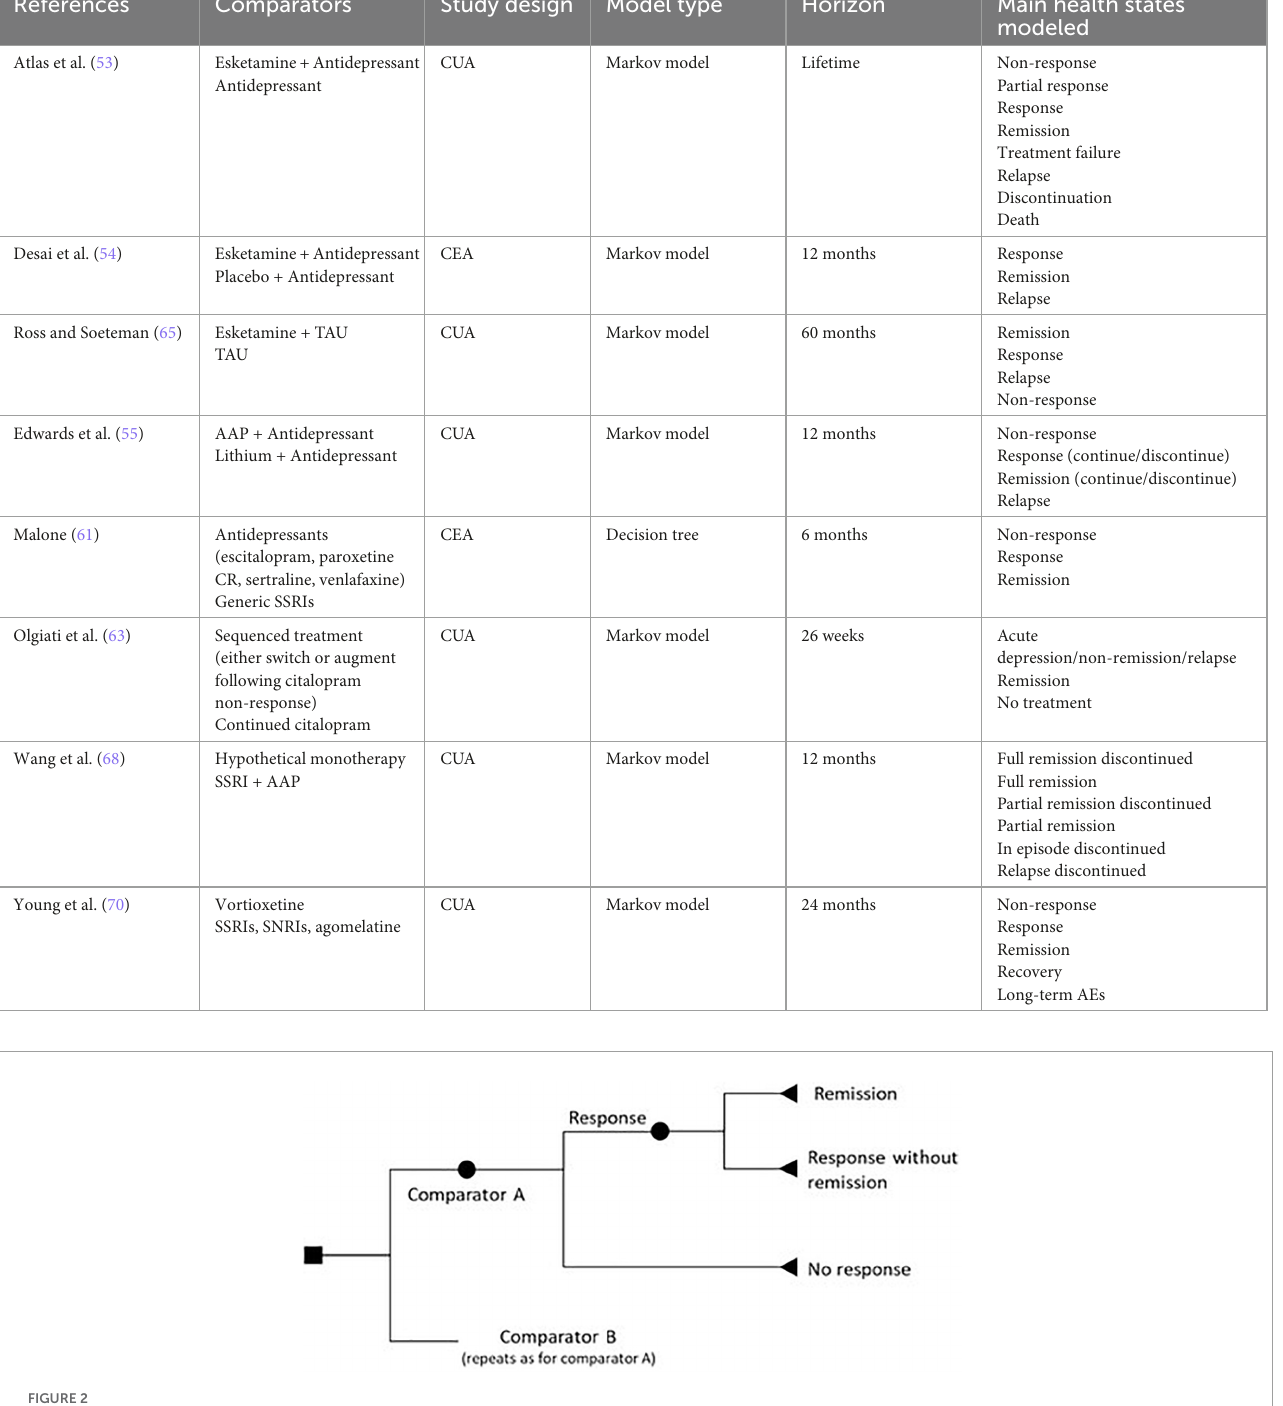
FIGURE2 Generic decision tree structure for economic evaluations in